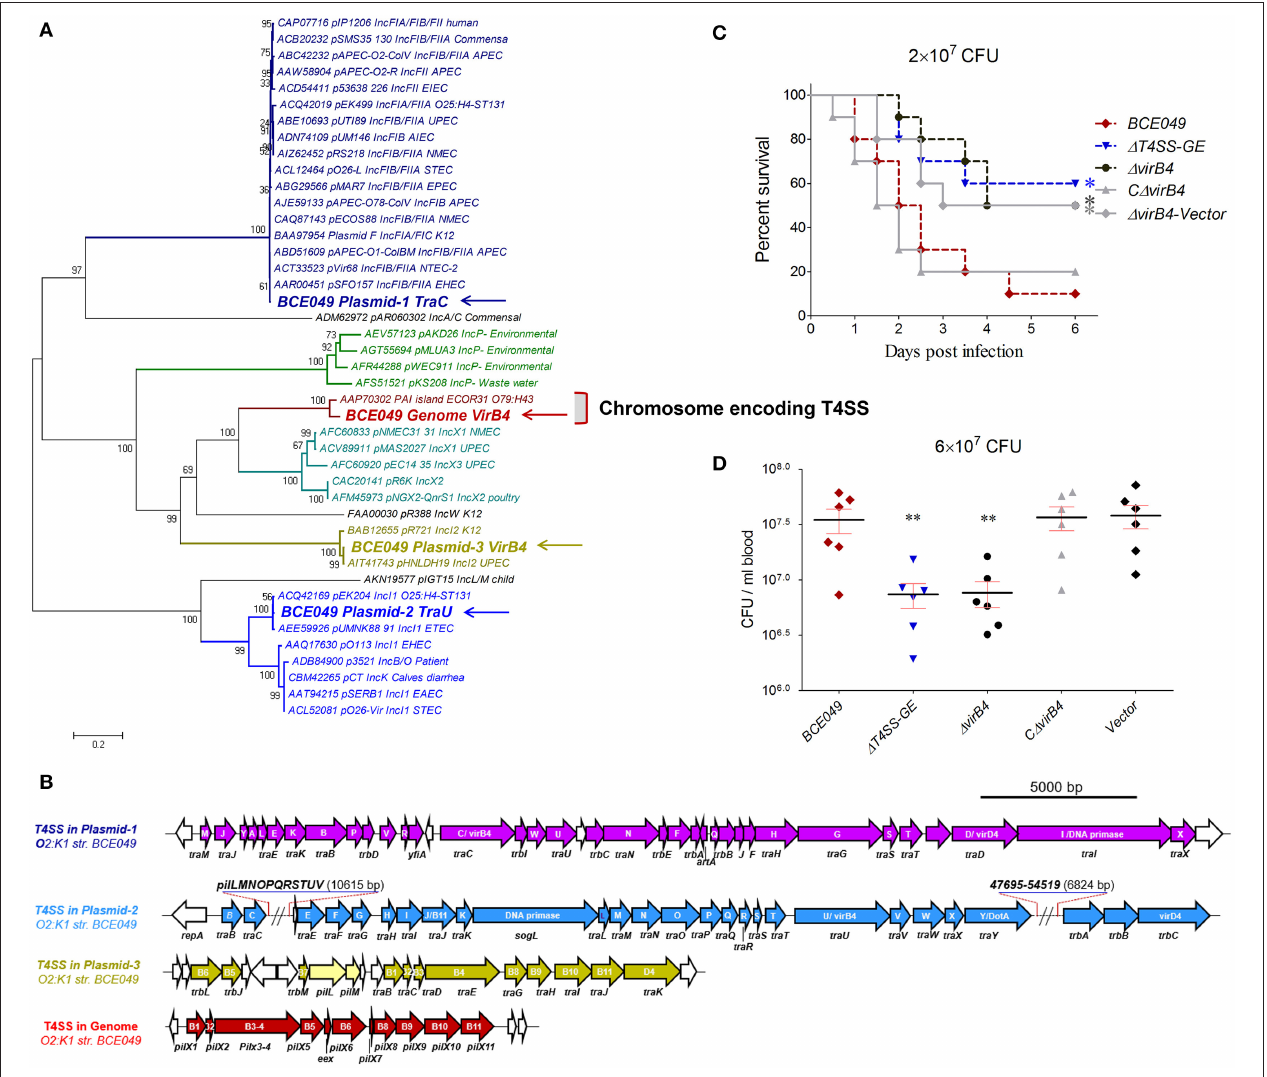
FIGURE 5 | Identification of a chromosome-encoding T4SS contributing to bacterial virulence. (A) Phylogeny-based genotyping of 43 T4SSs with available VirB4 homolog amino acid sequences from various bacterial strains. A neighbor-joining tree (bootstrap n = 1,000; Poisson correction) was constructed based on a ClustalW alignment of the VirB4 amino acid sequences encoded in T4SS loci from diverse E. coli pathotype strains. (B) The genetic organizations of four T4SS loci from strain BCE049. (C) Effect of T4SS-CE and VirB4 on ExPEC BCE049 pathogenicity. Survival curve of mice infected with 2 × 10 7 CFU/mouse bacteria (10 5-week-old mice per group). The data were compared with that of strain BCE049 and analyzed using the log-rank (Mantel–Cox) test (* P < 0.05). (D) Systemic infection experiments were conducted to assess bacterial proliferation in mouse blood as the description of Figure 4F legend (** P <